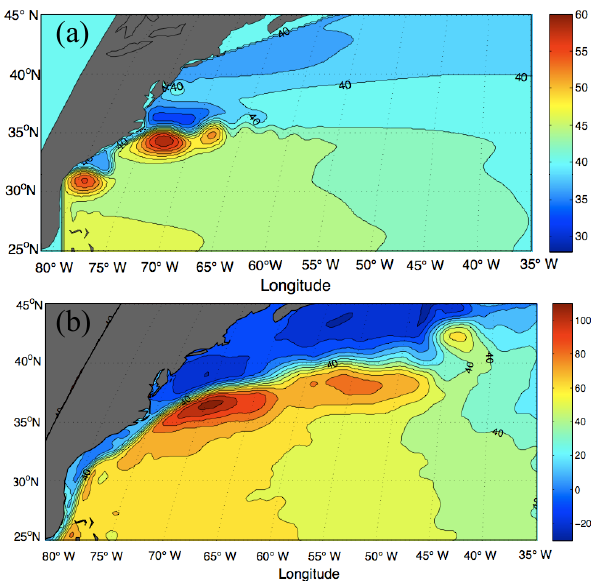
Fig. 2. (a) 26-yr time-mean of the simulated SSH (cm). (b) 18- yr (1993–2010) climatology of the absolute dynamic topography (distributed by AVISO/Cnes) (cm). A 40-cm offset has been added to the modeled SSH to make the modeled and observed GSE axis